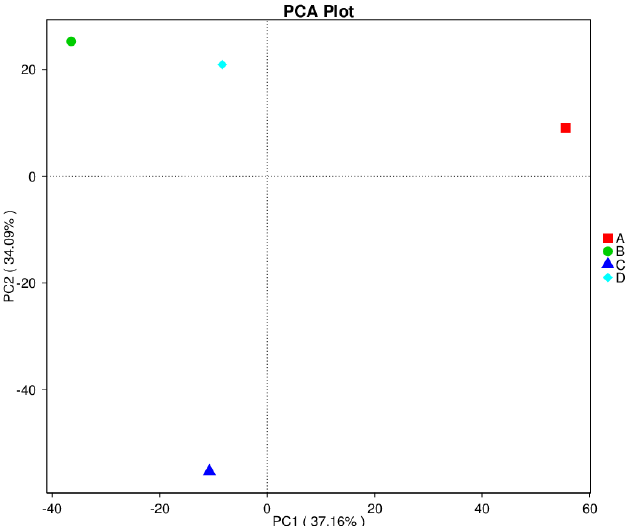
Figure 10. Unweighted pair-group method with arithmetic mean (UPGMA) (A, thermophilic of Harmanli site; B, mesophilic of Harmanli site; C, mesophilic of Yasno pole site; D, thermophilic of Yasno pole site). Yasno pole site).